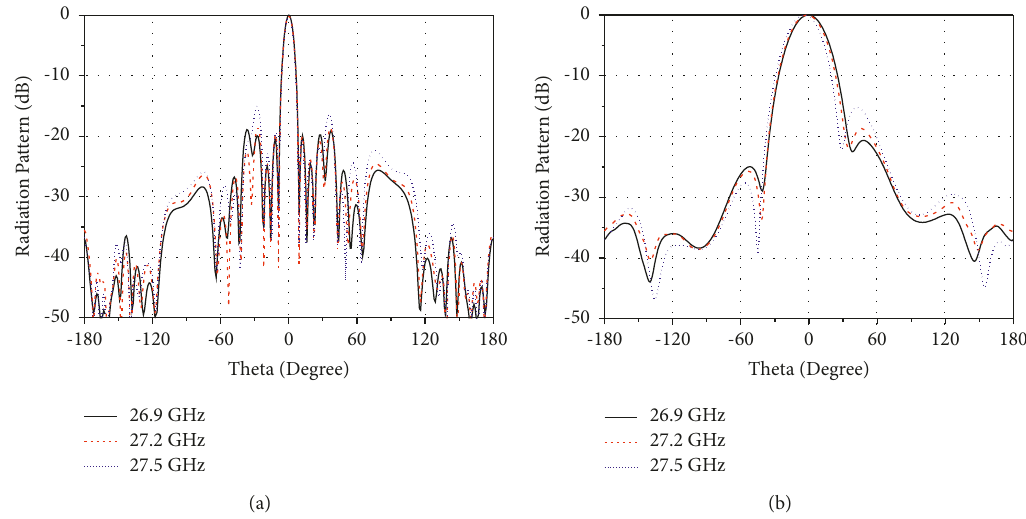
Figure 16: Simulated radiation patterns of the proposed 1 × 4 antenna array. (a) E-plane ( xoz ). (b) H-plane ( yoz ).